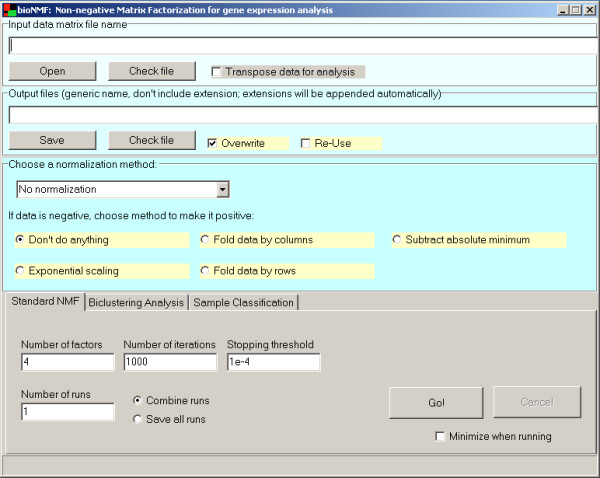
Main bioNMF window. The tool is divided into three main functional modules: data input, data transformation and analysis modules (standard NMF, bicluster analysis and sample classification). Standard NMF implements the classical Lee and Seung NMF algorithm. Bicluster analysis uses a sparse variant of the NMF model while Sample classification implements an unsupervised classification method that uses NMF to classify experimental samples.